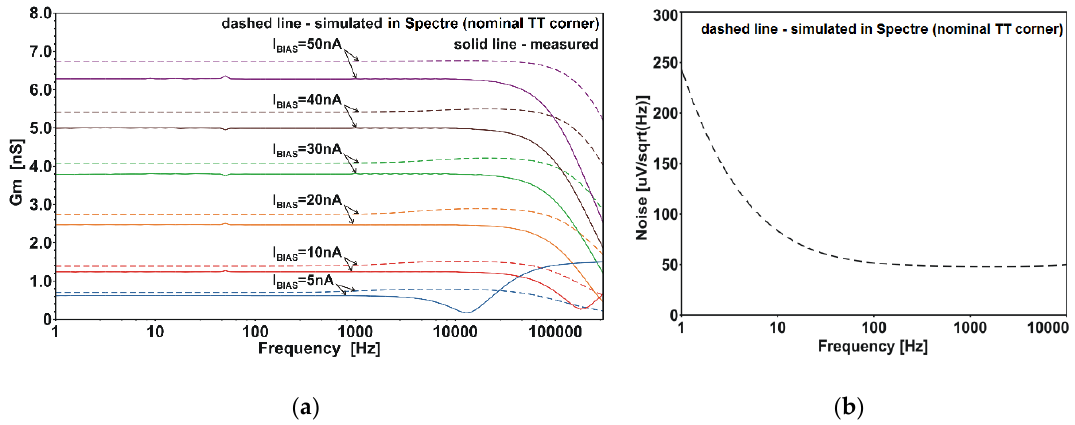
Figure 8. Small-signal characteristics: ( a ) of the transconductance; ( b ) of the input-referred noise. AC signal is applied to the inverting input V i − . DC levels on inputs are V i − = V i + = 0.5 V. The V DD is 1 V.